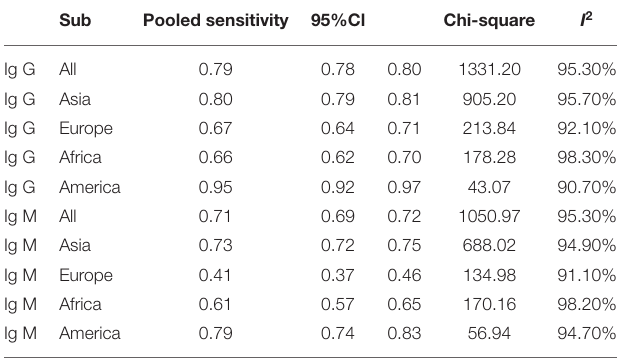
TABLE 1 | Subgroup analysis of sensitivities for IgG and IgM to predicting COVID-19 diagnosis.